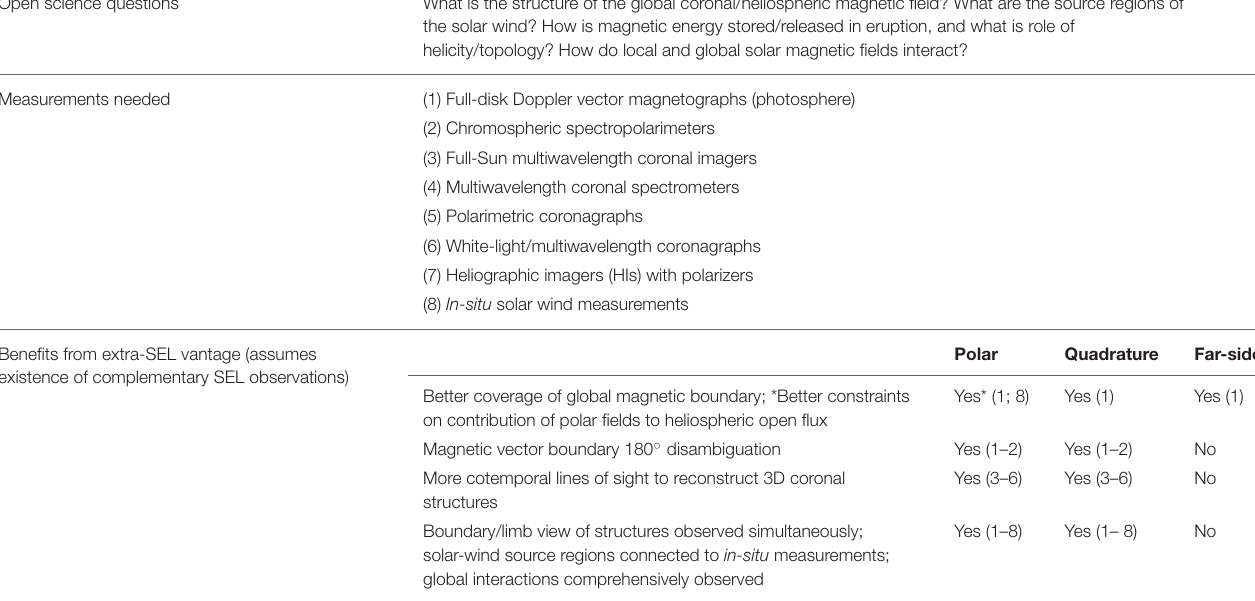
TABLE 2 | Solar atmosphere/global connections studies enabled by extra-SEL